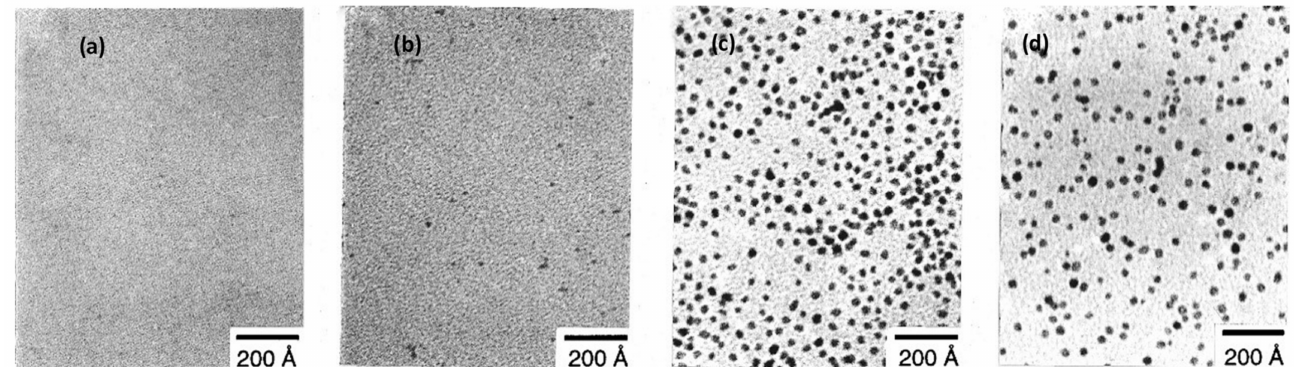
Figure 2. Pt nanoparticles of different diameters prepared by chemical methods: ( a ) 10 min, ( b ) 20 min, ( c ) 30 min, and ( d ) 180 min. (PVP/Pt = 10, [methanol] = 90 vol %). Reprinted with permission from Ref. [55]. Copyright 1999 American Chemical